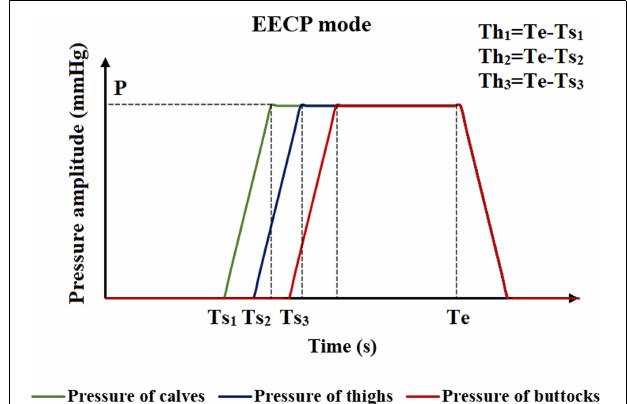
FIGURE 2 | Schematic diagram of the EECP mode. Where Ts 1 , Ts 2 , and Ts 3 are the moments when the counterpulsation cuffs of each part start to inflate. P is the pressure amplitude, and Th 1 , Th 2 , and Th 3 are the pressurization durations of counterpulsation cuffs. Te is the deflation